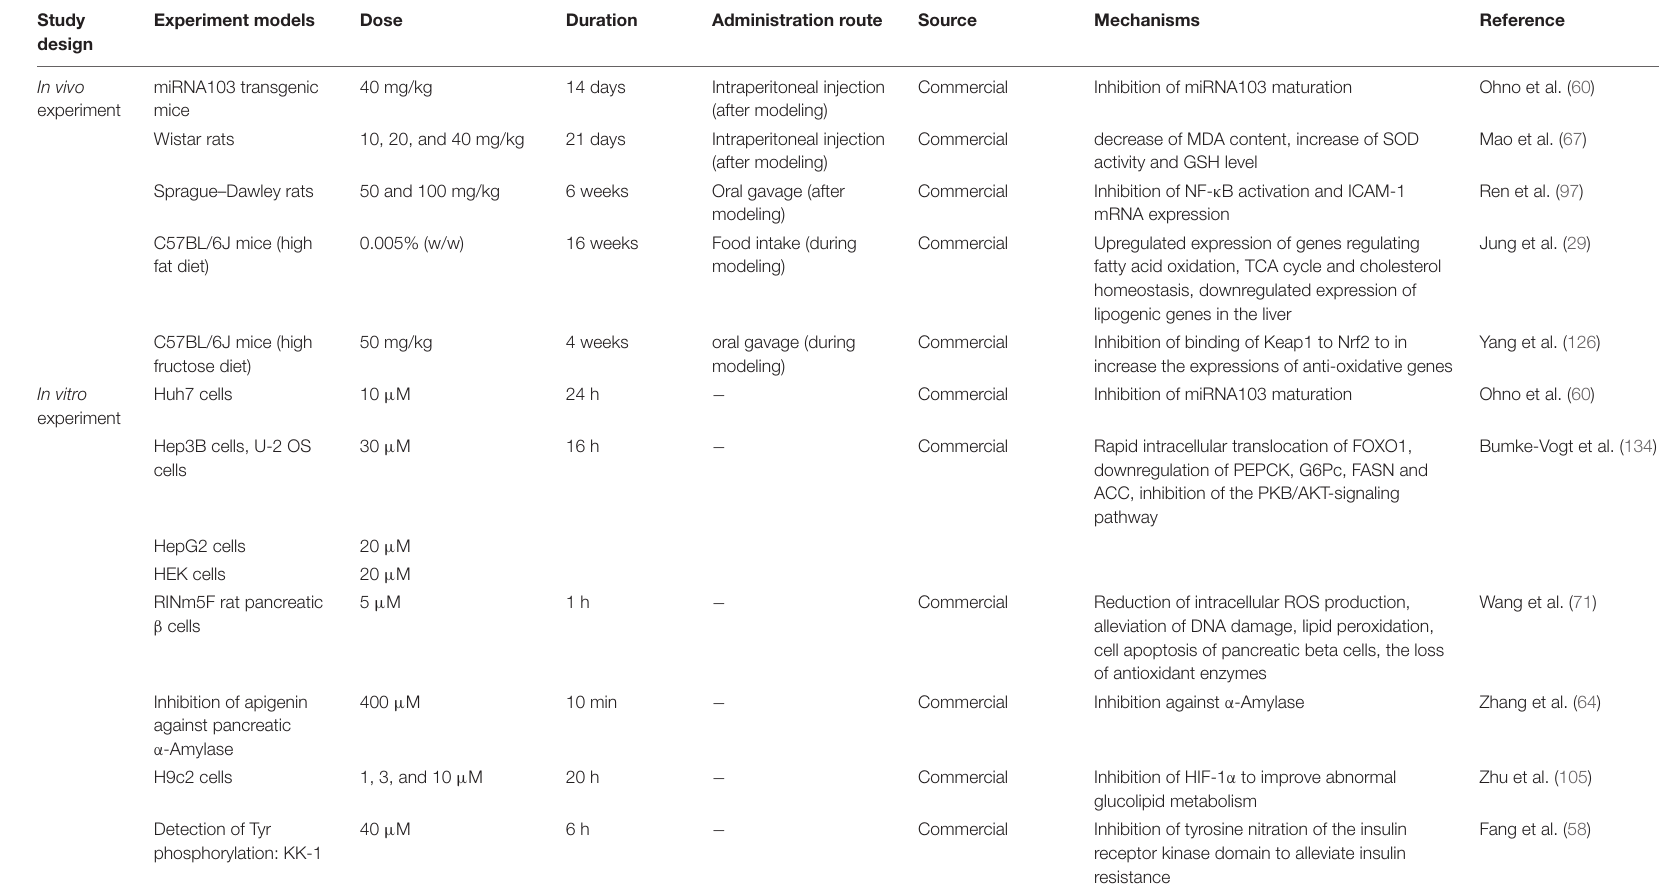
TABLE 2 | Experiment designs and effects of apigenin on diabetes ( in vivo and in vitro